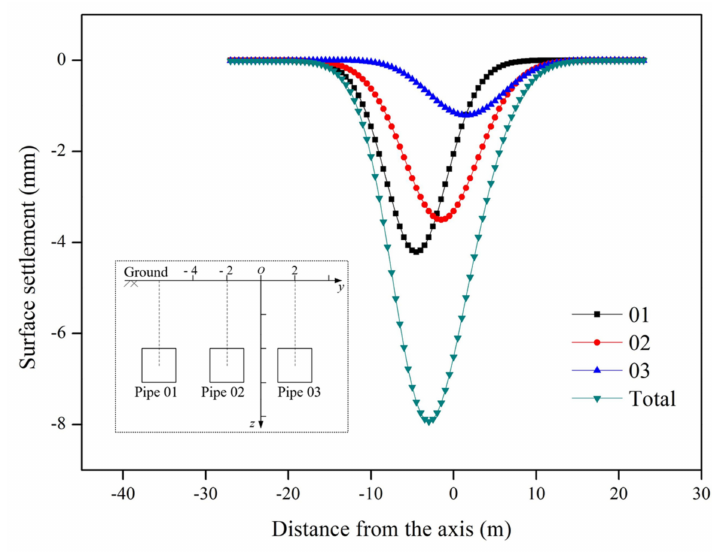
Figure 13. Curves of transverse ground surface settlement.